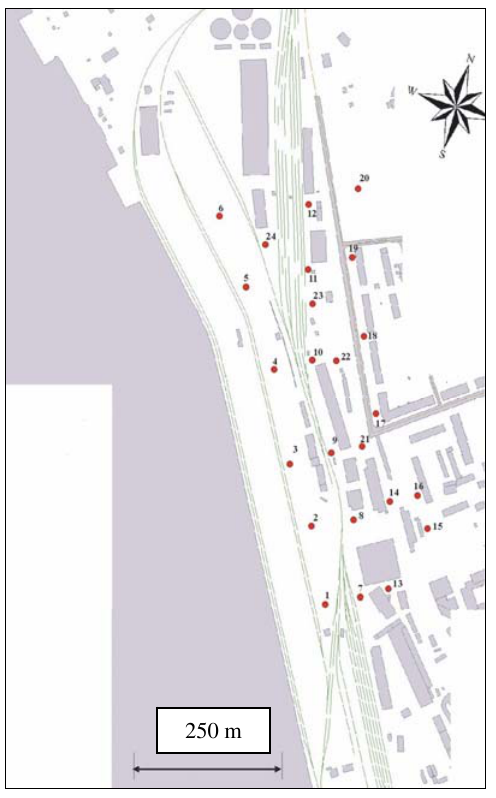
Fig 1. Measuring points of noise level on JSC KLASCO territory Ekvivalentinio garso lygis gamybin ė se patalpose ir teritorijose 85